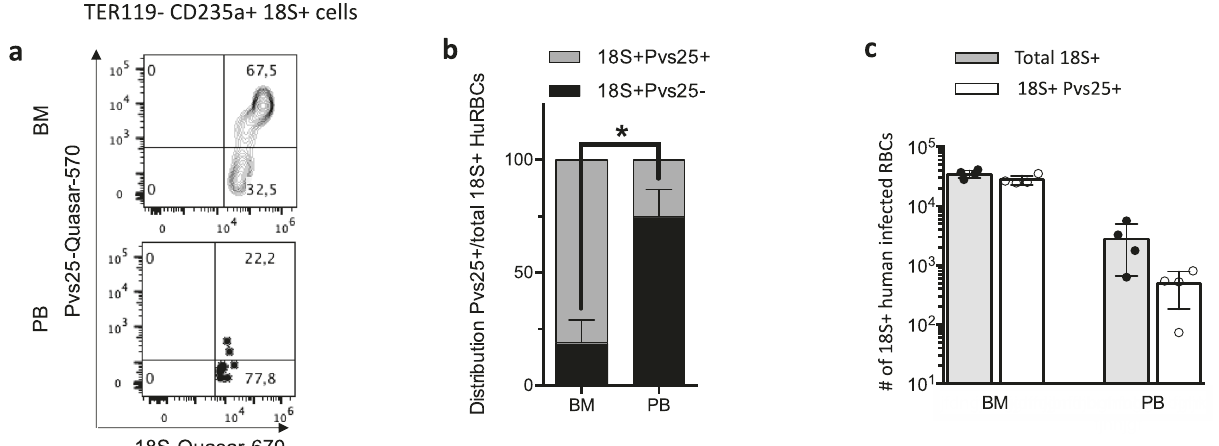
Fig. 3 HIS-HEry chimeras support de novo P. vivax sexual differentiation. HIS-HEry mice were infected with the Pv1 isolate, and RBCs were examined at 7 days post-infection. a Representative FlowFISH plots show the proportions of P. vivax gametocyte-speci fi c, Pvs25 RNA expression in all gated TER119 − CD235a + P. vivax 18S + (highlighted parasitized human cells in the BM ( upper panel ) and in the PB ( lower panel ). b Distribution of Pvs25 + 18S + gametocytes ( gray bars ) versus Pvs25 − 18S + asexual blood stages ( black bars ), among BM and PB human CD235a + RBCs; n = 4 individual mice. Two-tailed paired Student ’ s t -test was performed to compare the representation of Pvs25- 18S + RBCs between the BM and PB samples. * P -value = 0.0004; Mean ± SDs are: BM Pvs25- mean = 19.13±17.5; PB Pvs25- mean = 74.83 ±11.94. c Mean numbers of total 18S + infected RBCs ( open bars ) and Pvs25 + 18S + gametocytes ( gray bars ) in the BM (per femur) and in PB (per ml). n = 4 individual mice (same as in b ). Mean ± SDs are: BM total 18S += 34,793 ±5367; BM